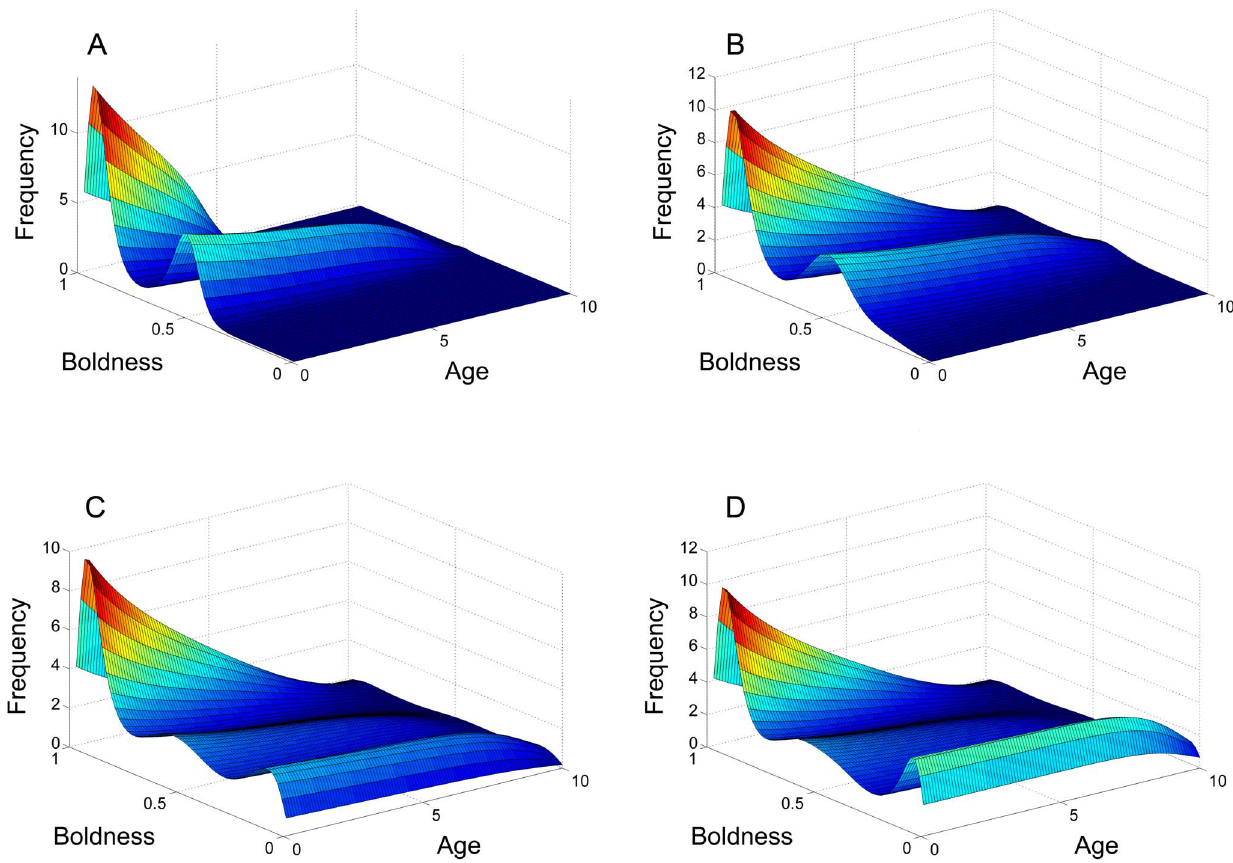
Figure 2. Evolution of the population over time. The system was numerically simulated using an Upwind scheme and stopped at certain t values. Panels A, B, C and D correspond to t ~ 10 , 30 , 60 and 120 respectively. Bold individuals appear to experience the fast growth due to the future versus current reproduction trade-off.